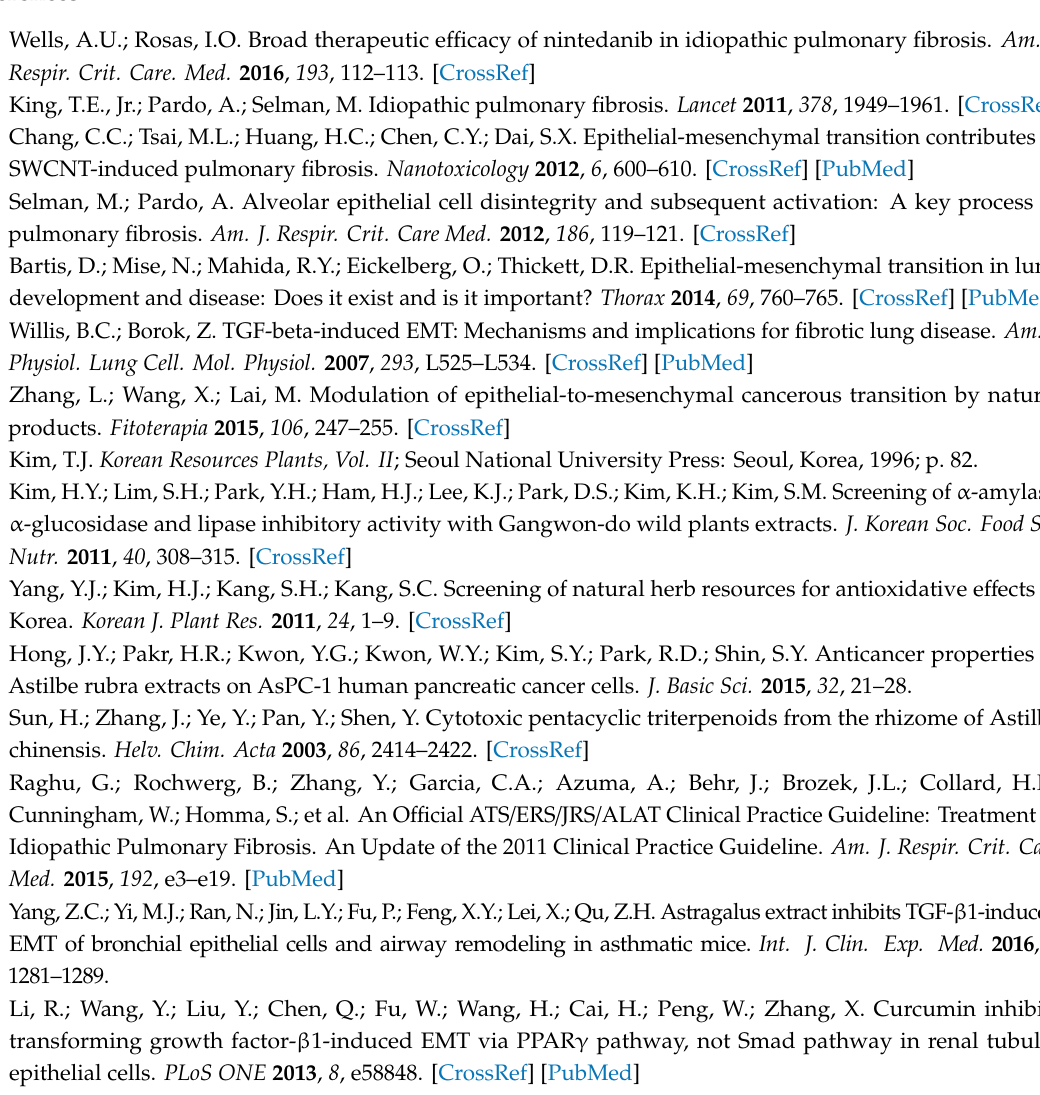
Supplementary Materials: The following are available online, Table S1: Primers used in qRT-PCR. Figure S1: A549 cells were treated with di ff erent concentrations of ( A ) extracts, ( B ) solvent fractions of Astilbe rubra (left, fractions from the aerial part of A. rubra ; right, fractions from the rhizome of A. rubra ). Cell viability was evaluated using the WST-1 assay. Figure S2A: 1H-NMR spectrum of β -peltoboykinolic acid isolated from Astilbe rubra (CDCl 3 , 850 MHz). Figure S2B: 13 C-NMR spectrum of β -peltoboykinolic acid isolated from Astilbe rubra (CDCl 3 , 100 MHz). Figure S3: Structure of β -peltoboykinolic acid. Figure S4: A549 cells were treated with di ff